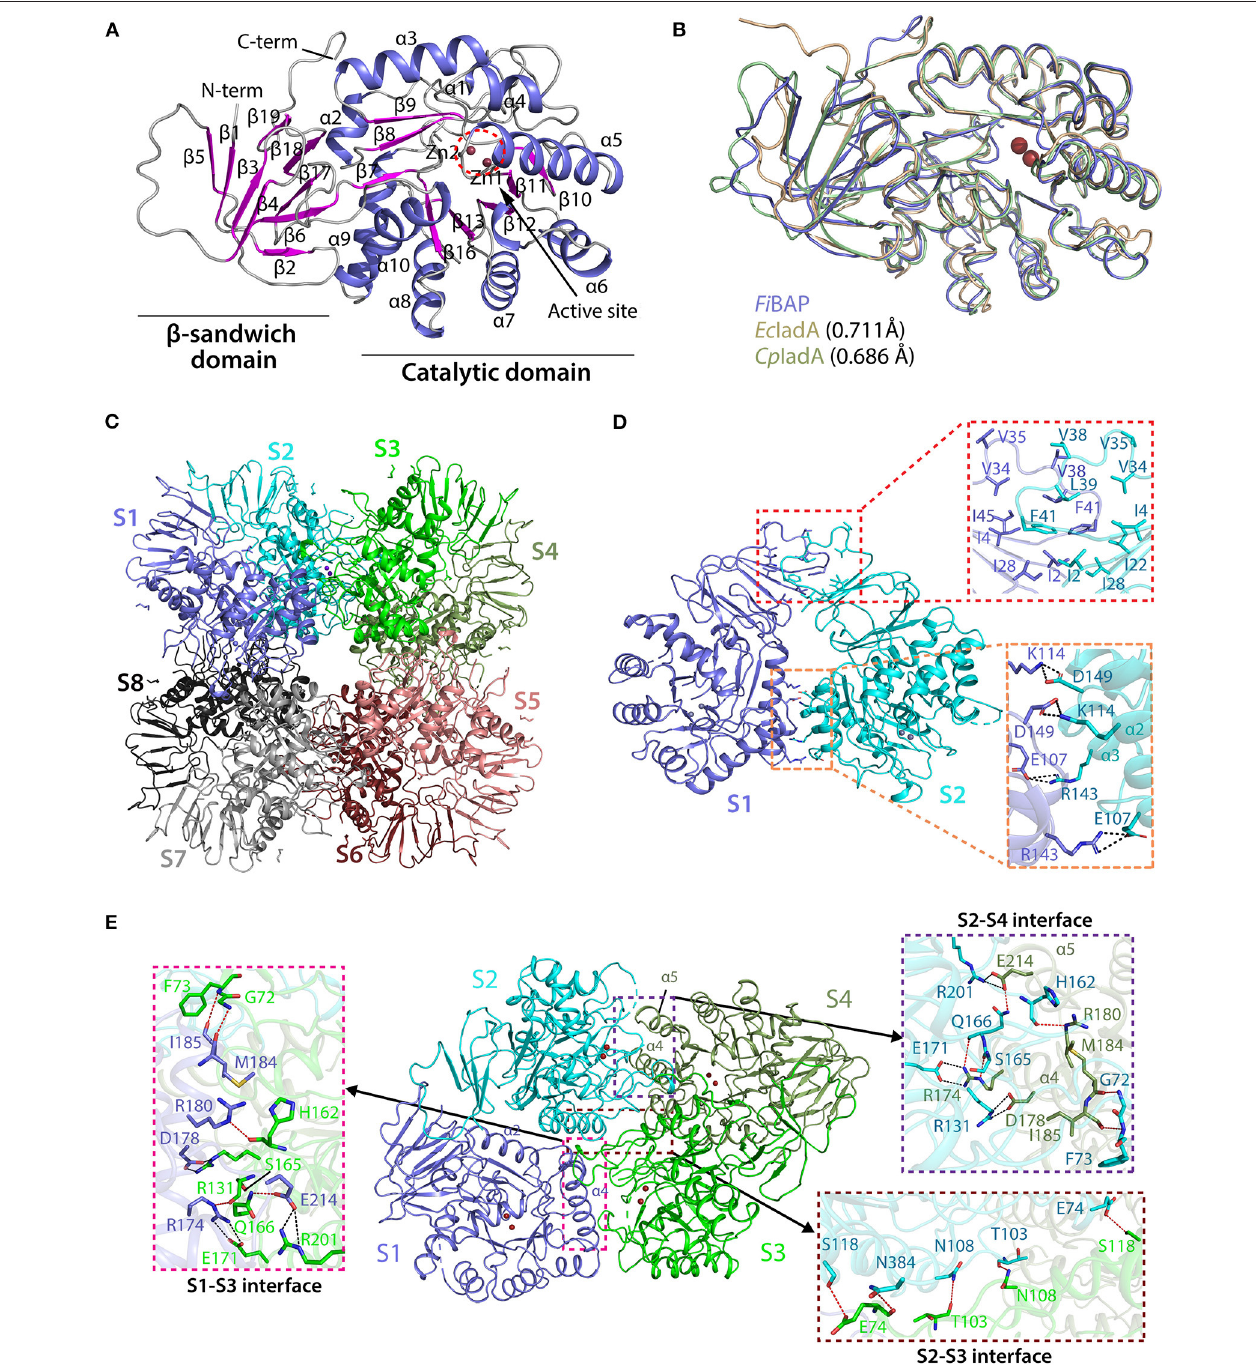
FIGURE 4 | Crystal structure of Fi BAP. (A) Domain structure of monomeric Fi BAP. The monomeric subunit of Fi BAP consists of two domains; an N-terminal β -sandwich domain and a C-terminal catalytic domain. The structural elements from the N- to C- termini of the protein are labeled. The active site (marked as a dotted red circle) contains two zinc metals (Zn1 and Zn2) located in the catalytic domain. (B) Structural alignments of Fi BAP with structural homologs Ec IadA (PDB ID 1ONW) and Cp IadA (5XGW). RMSD values are indicated in parentheses. (C) Quaternary structure of Fi BAP comprising dimers of two tetramers. Symmetry-related molecule analysis reveals Fi BAP to be an octamer of eight subunits (S1–S8, subunits colored differently). (D) Interactions at the interface between each subunit in a dimer. Dimers formed from two subunits (S1 and S2) are shown. The top red box shows hydrophobic interactions between β -sandwich domains, and the bottom salmon box shows salt bridges formed between catalytic domains of each subunit. (E) Dimer-dimer interactions. Interface interactions between the S1–S2 dimer (slate blue and cyan) and the S3–S4 dimer (green and smudge) are shown. The molecular interactions at three contact points, the S2–S4 interface (purple box), the S2–S3 interface (brown box), and the S1–S3 interface (magenta box), are shown in zoomed representation.